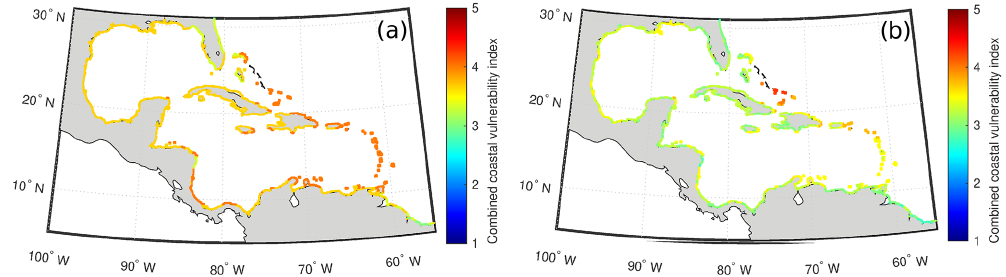
Figure 10. Coastal vulnerability metrics; (a) combined based on mean annual rate of sea level rise, mean wave height and great diurnal tidal range and (b) as (a) plus maximum wind